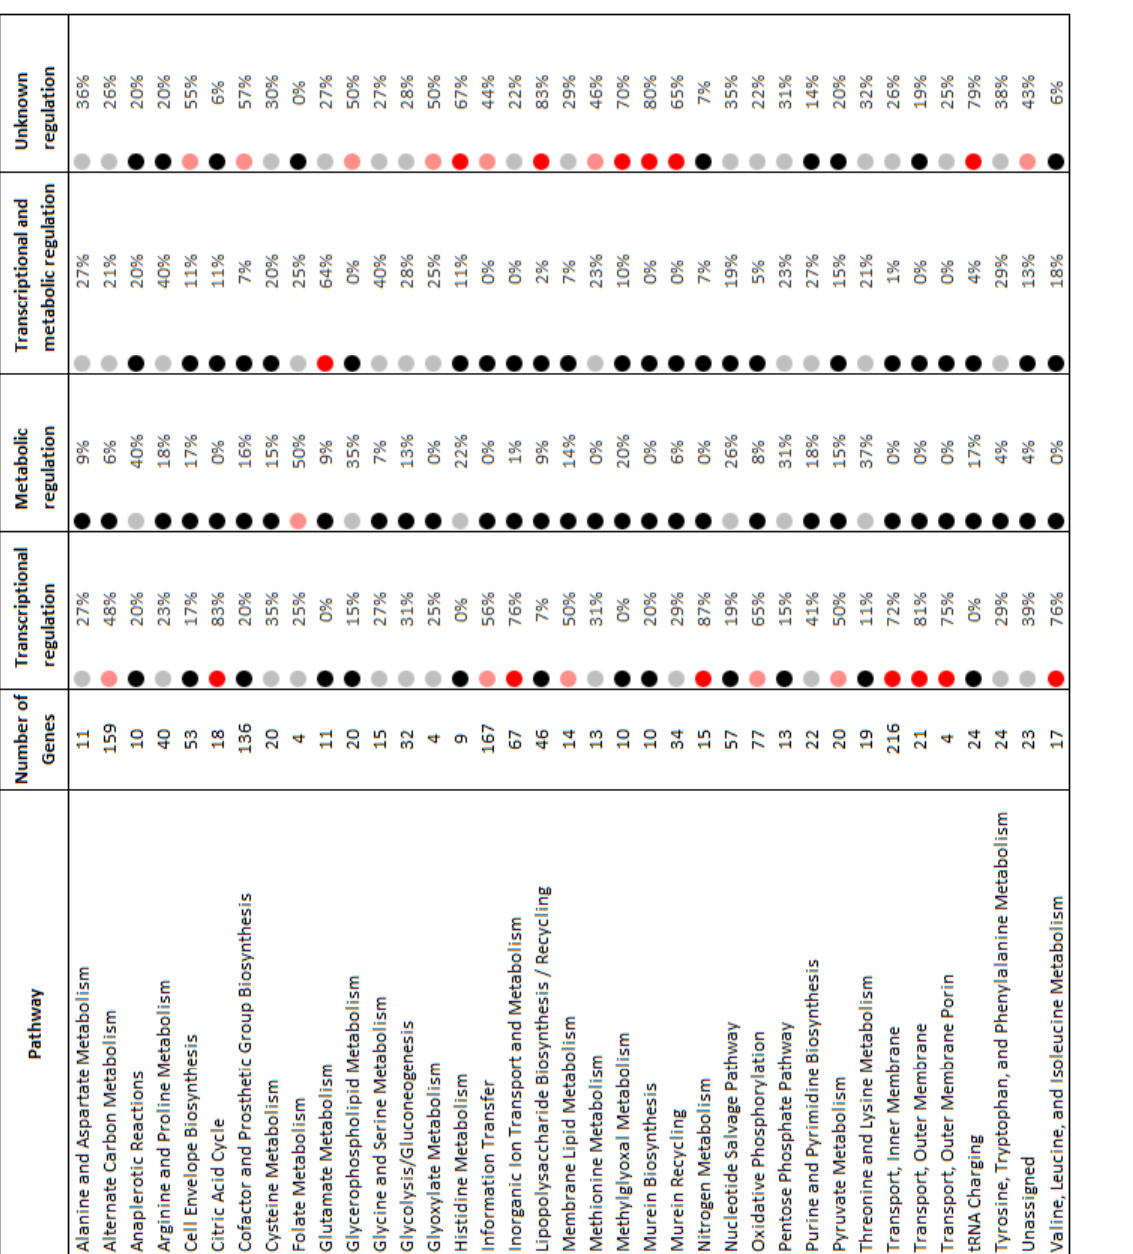
Table 1: Effect of transcriptional, enzymatic and co-regulation in E. coli pathways. For each gene associated with a particular pathway it was determined if there are transcriptional regulations (i.e. a link between genes), enzymatic regulations (i.e. a link between a metabolite and a non- regulatory gene (nRG)) or both types of regulation (co-regulation). Unknown regulation denotes the absence of regulatory